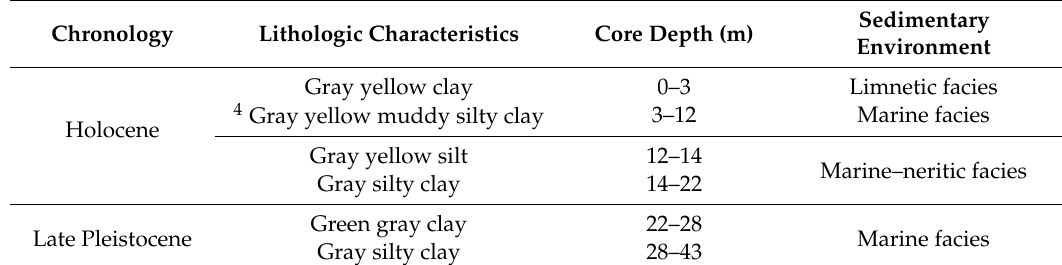
Table 4. Geological conditions for